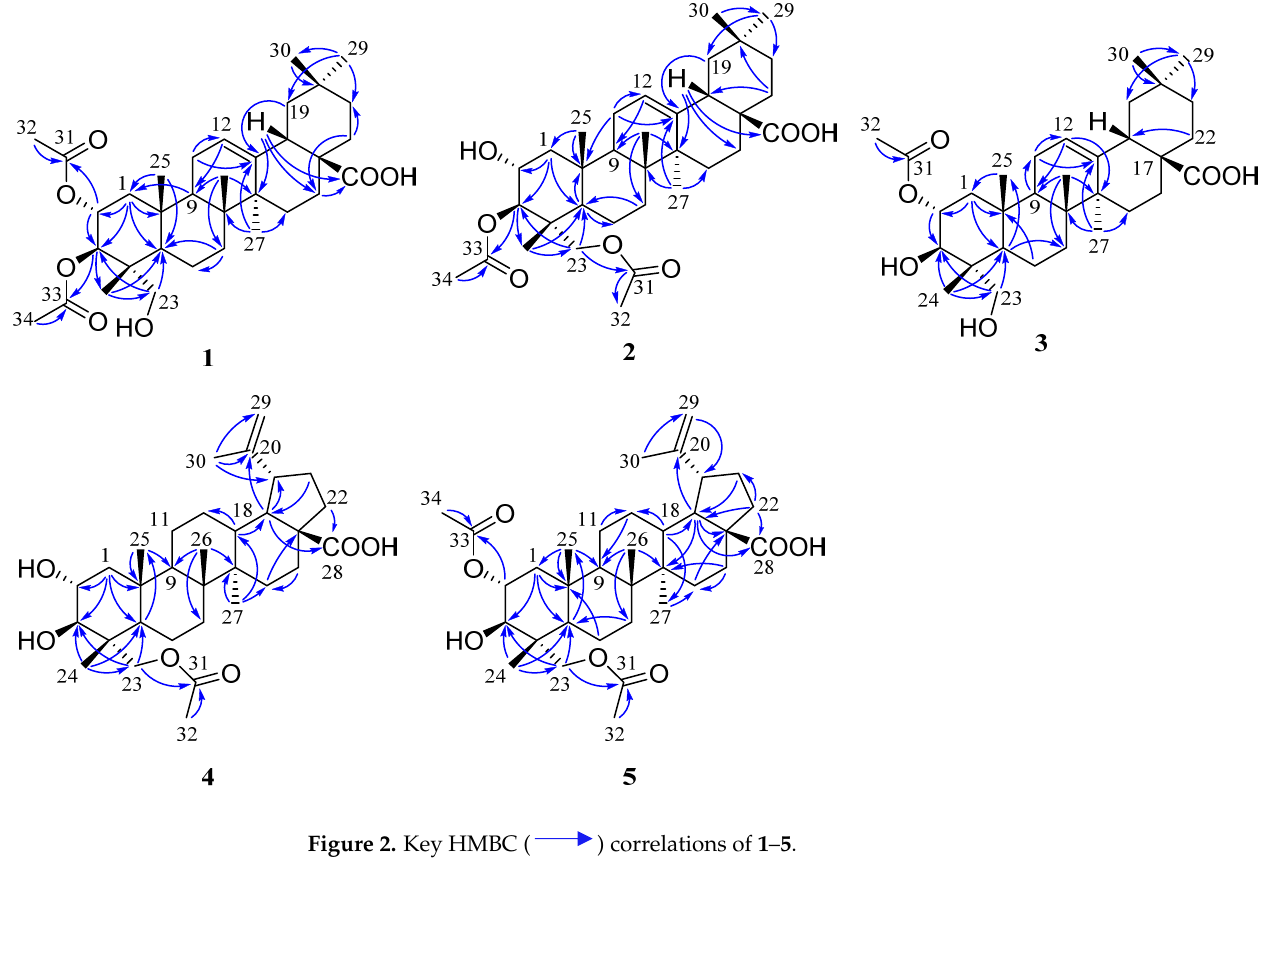
Plants 2023 , 12 , x FOR PEER REVIEW 3 of 12 2. Results